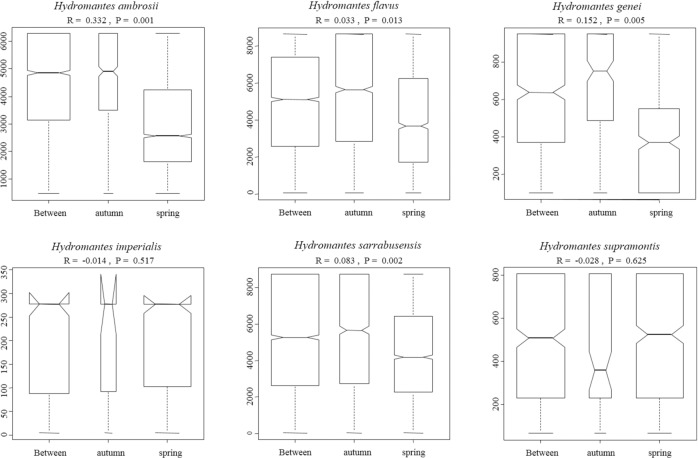
Box whisker plot of ANOSIM analysis comparing the seasonal variation of the diet of Hydromantes.Figures show the variation between and within each different seasons (autumn and spring). Boxes indicates values from 25th (bottom) to 75th (top) percentile; horizontal black line indicate the median; box width is proportional to sample size.